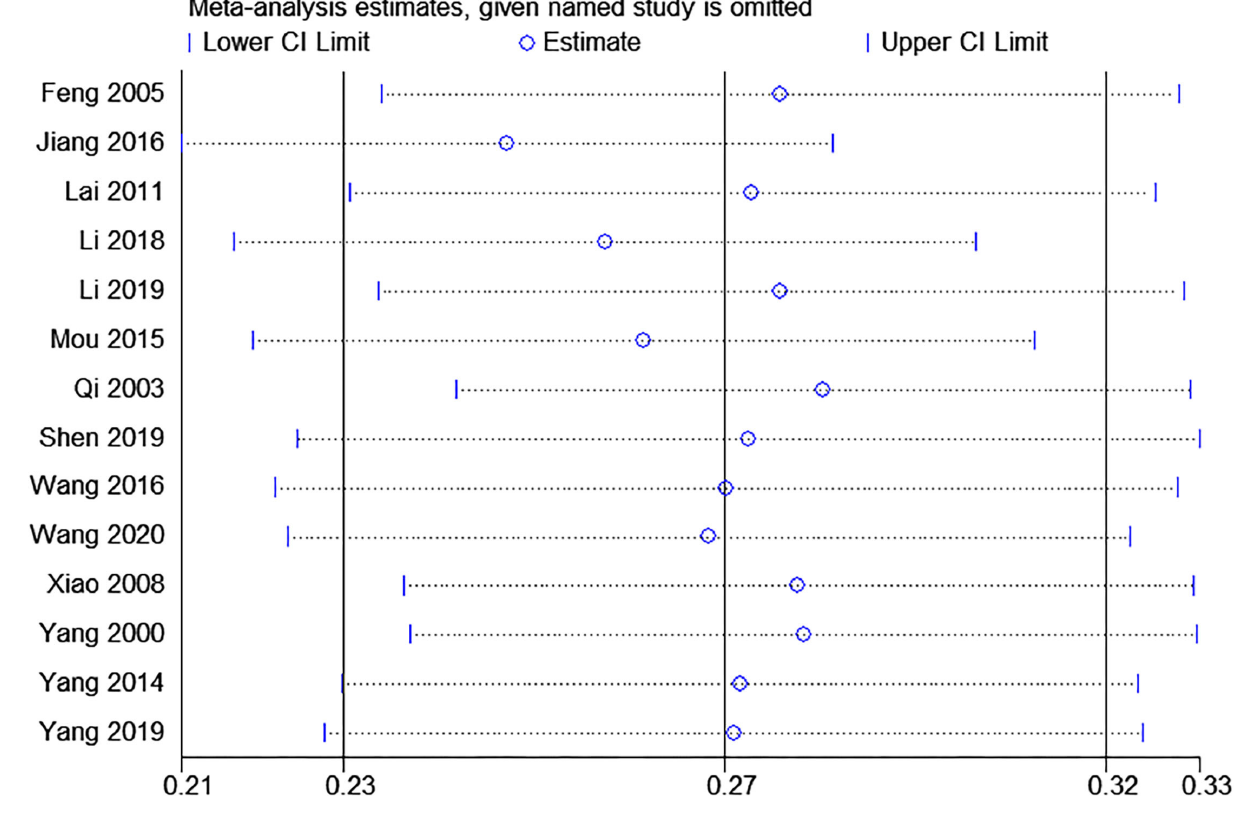
FIGURE 3 | Sensitivity analysis with jackknife